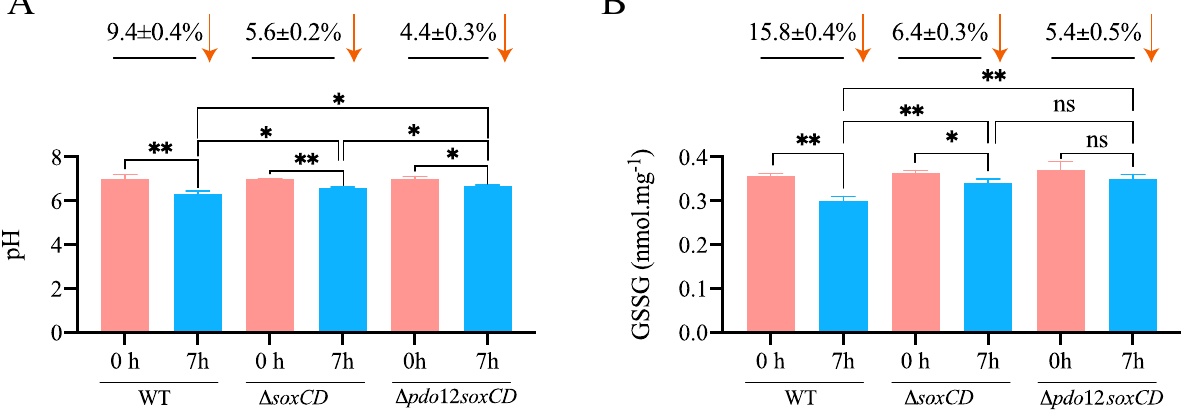
Figure 3. pH and GSSG detection of wild-type JMP134 and the mutants. Cells were harvested, washed, and resuspended at an OD 600 of 2.0 in 100 mM HEPES buffer, pH 7.0. When measuring the pH, HEPES buffer was replaced with 1% physiological saline. Then, 1 mM thiosulfate was added to initiate the reaction. The pH of the suspensions was measured ( A ), and the GSSG of the cell lysate ( B ) was determined at 0 and 7 h. WT, wild-type C. pinatubonensis JMP134. *: p < 0.05; **: p < 0.01. ns: not